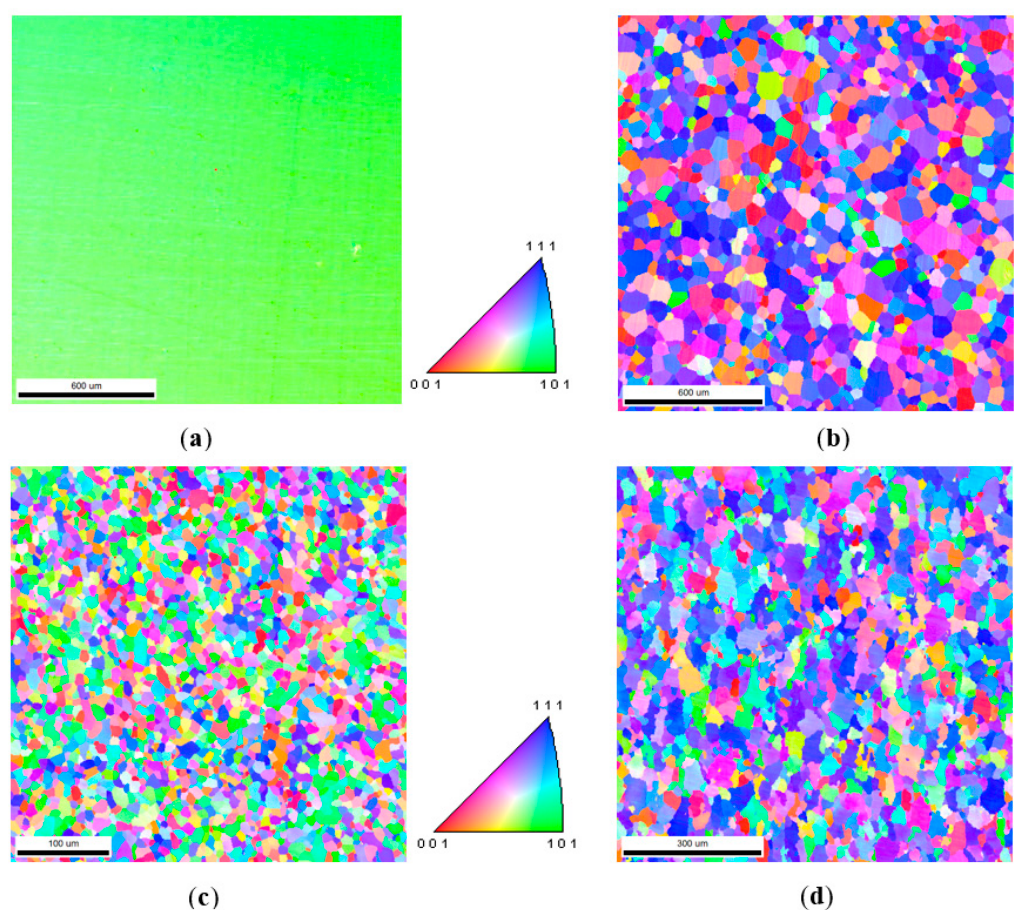
Figure 12. Orientation maps of 4 materials: ( a ) 30SQG120, ( b ) B50A470, ( c ) X60, and ( d ) X70. According to the method described above, with the orientation of each grain represented by different colors in Figure 12, the MCE model was obtained. By averaging the contribution of individual grains with a direct method, the MCE results based on the consideration of the direction of the external magnetic field were finally obtained (Figure 13).